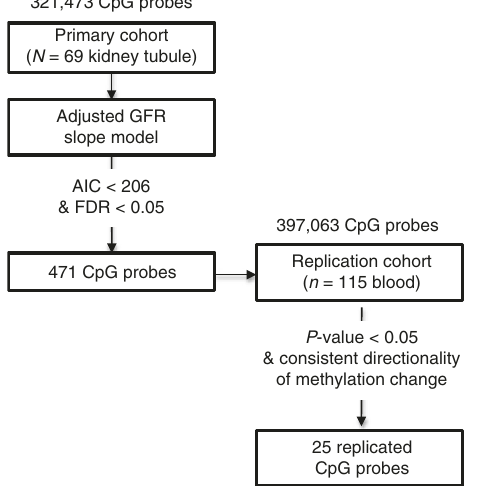
Fig. 5 Replication of methylation probes associated with kidney function decline 471 methylation probes signi fi cantly improved the baseline kidney function decline weighted linear regression model beyond baseline variables (Age, baseline GFR, and Diabetes) (AIC < 206 and FDR < 0.05). Of these 471 probes, 432 probes were assessed in the replication cohort in peripheral blood. 39 probes were excluded due to poor data quality. 52 methylation probes were associated with Adjusted GFR slope when adjusted for Age, Sex, reaching end stage renal disease (ESRD), duration of diabetes, mean blood pressure, hemoglobin A1C, as well as cell type heterogeneity using linear regression ( p -value < 0.05). Of these 52 probes, 25 probes maintained directional consistency across the two data